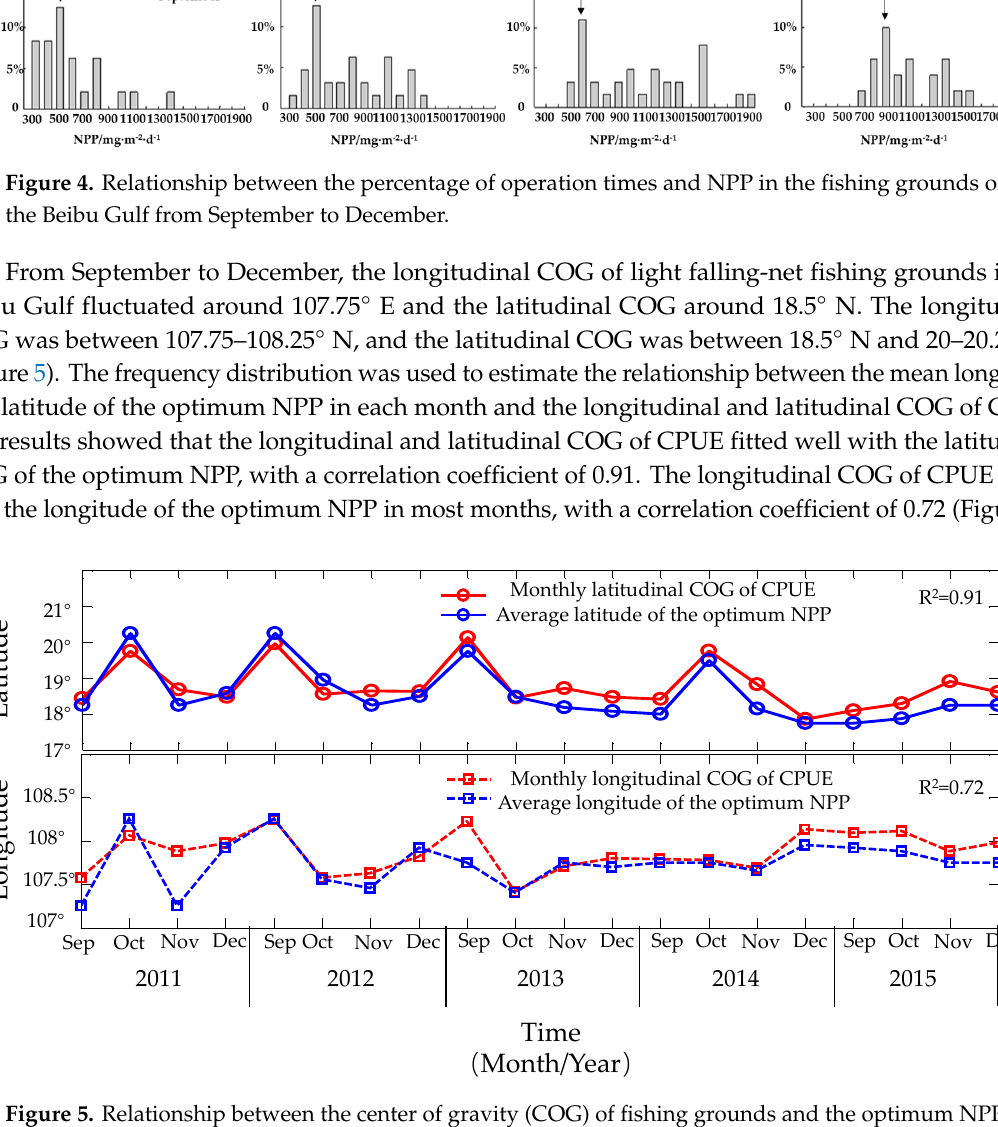
Figure 5. Relationship between the center of gravity (COG) of fishing grounds and the optimum NPP in the Beibu Gulf.